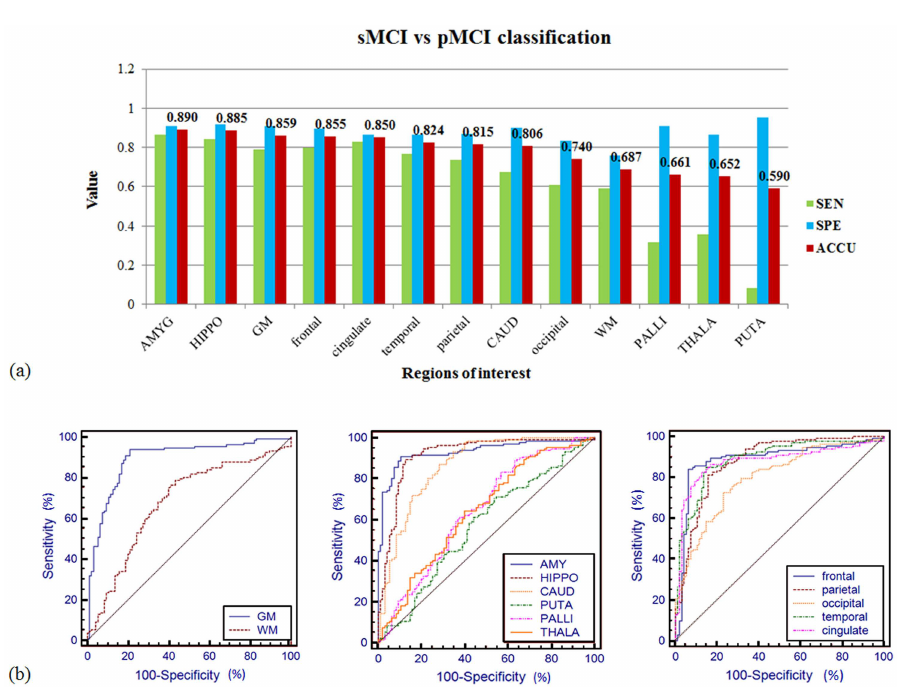
Fig 5. (a) Classification sensitivity (green), specificity (blue), and accuracy (red) of stable MCI versus progressive MCI subjectswith different ROIs. High rankedROIs includedamygdala,hippocampus, the whole-brain gray matter, frontal lobe, and cingulatecortex, with which classification accuracy exceeded85%. Sensitivity for globuspallidus,thalamus, and putamen was substantially low which resultedin bad performance in discrimination. (b) The ROC curve of the prediction accuracy betweenstable MCI versus progressive MCI. The AUC reachedup to 0.932 for amygdala(middle-blue curve), and 0.918 for hippocampus (middle-maroon